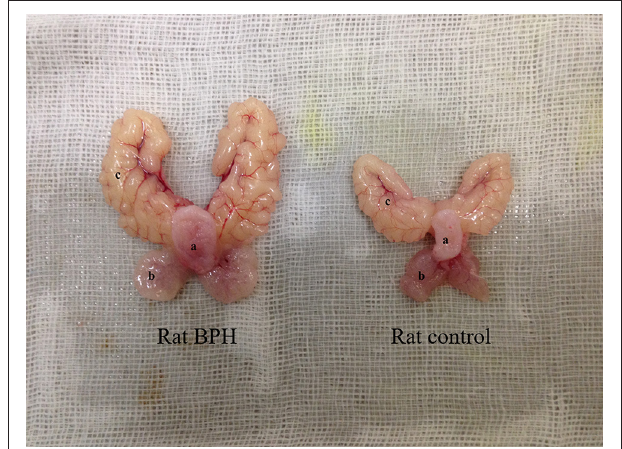
FIGURE 1 | Typical photograph from a BPH and control rat. (a) bladder, (b) ventral prostate, (c) seminal